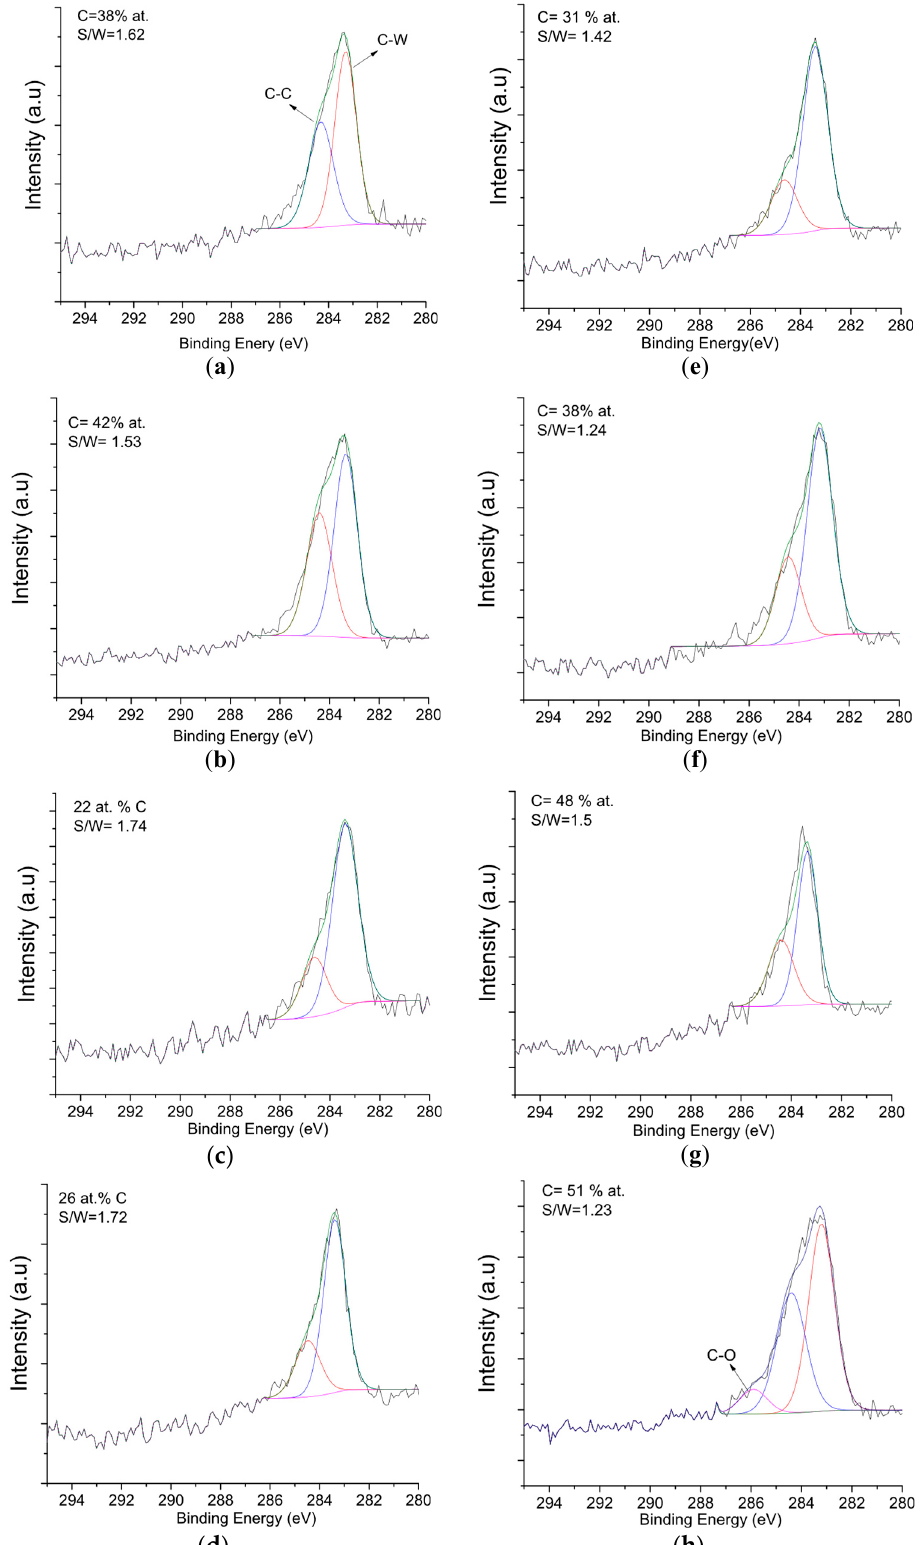
Figure 4. XPS spectra acquired in the C1s region of interest after sputter cleaning: ( a ) D1-300; ( b ) D1-450; ( c ) D2-21; ( d ) D2-17; ( e ) D3-21; ( f ) D3-21; ( g ) D4-28; ( h ) D4-38.